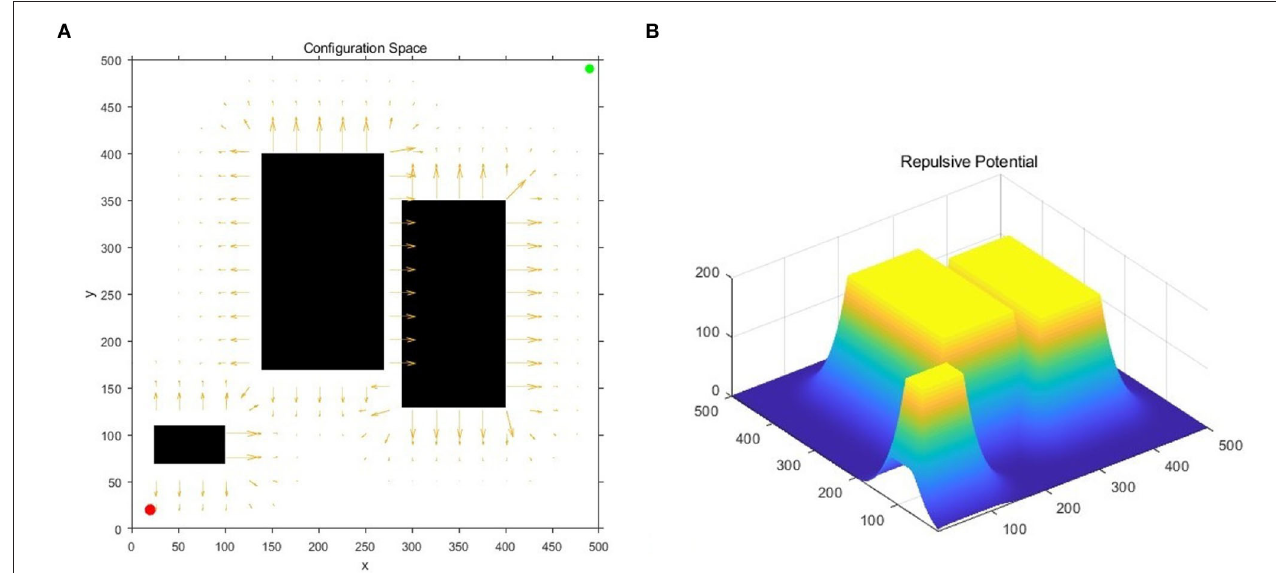
FIGURE 1 | Obstacle repulsive potential field experienced by random samples: (A) The diagram of the potential field direction; (B) The diagram of the potential field